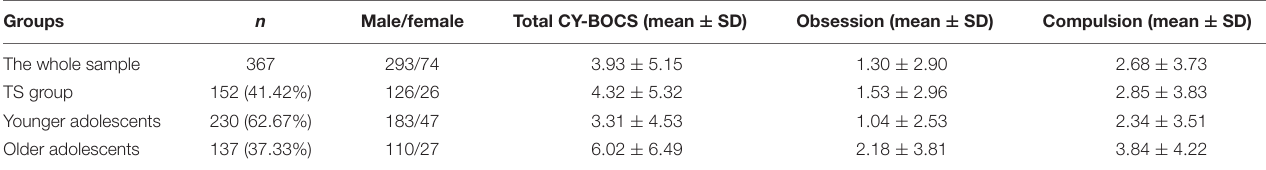
TABLE 1 | The clinical characteristics for the whole sample and different